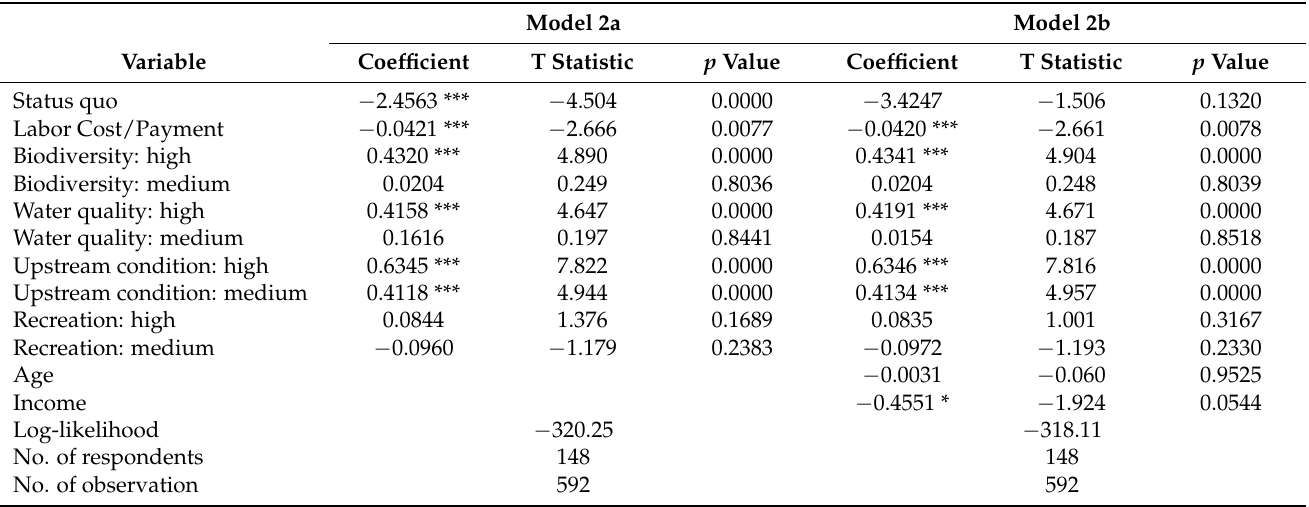
Table 7. The CL coefficient estimates for the WO case’s labor treatment using two models: no socioeconomic factors (Model 2a) and socioeconomic variables (Model 2b).